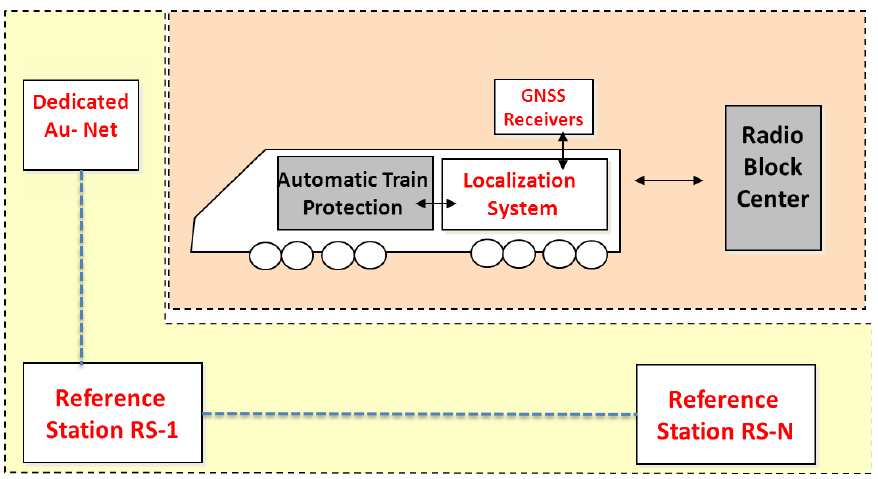
Figure 3. Satellite-based train control system (3InSat